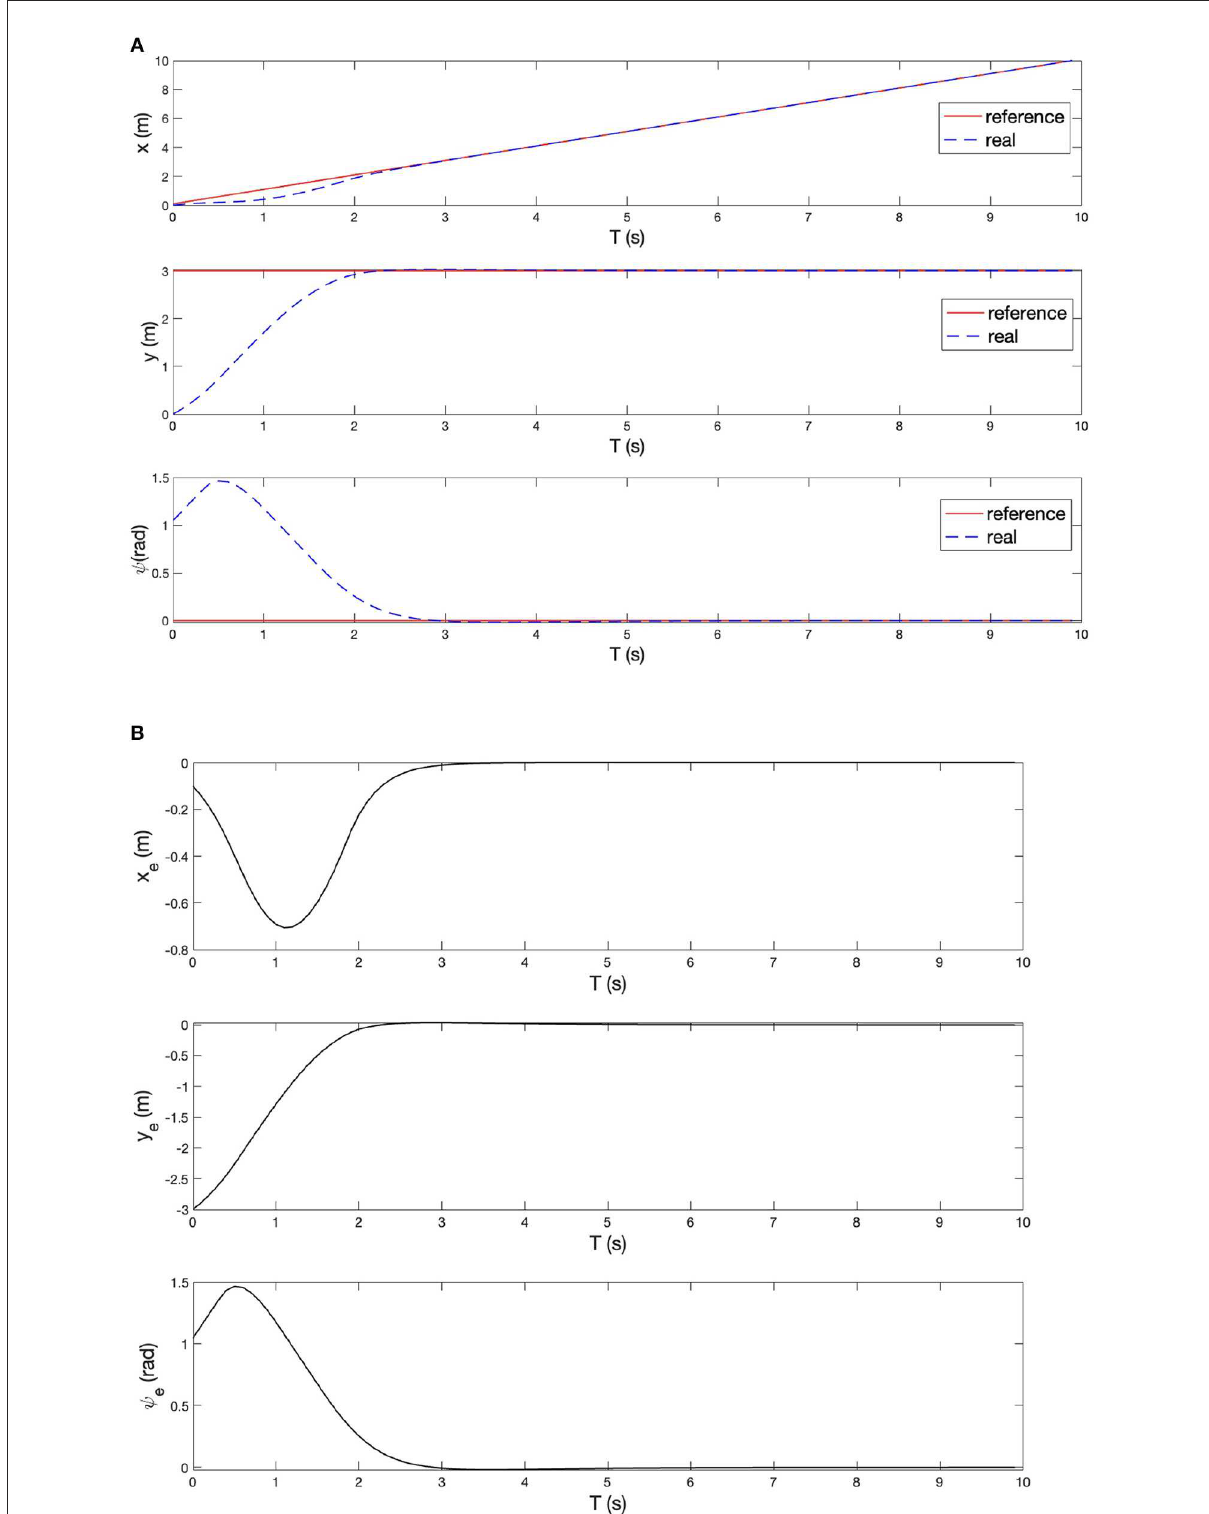
FIGURE9 (A) Longitudinal position, lateral position, and yaw angle of the reference trajectory and of the baby stroller. (B) Longitudinal error, lateral error, and yaw angle error between the baby stroller and the reference